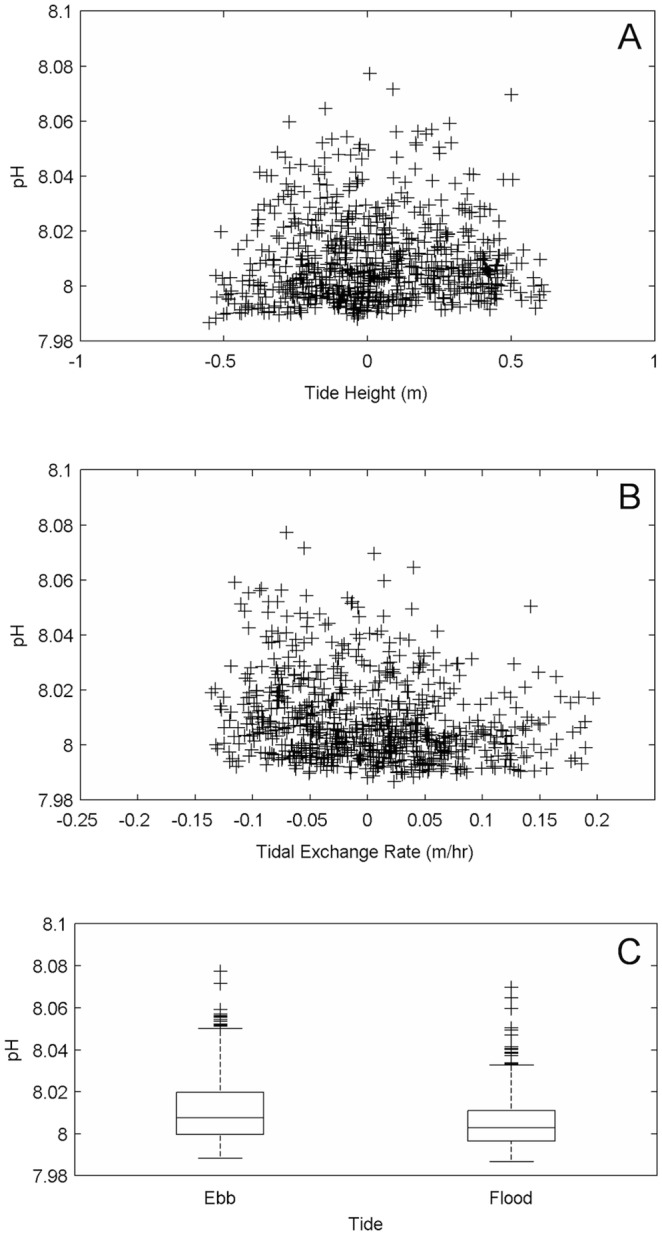
Relationship between pH and tides observed at Cape Evans.Panels show pH and tidal height (A), tidal exchange rate (B), and ebb versus flood stage (C).